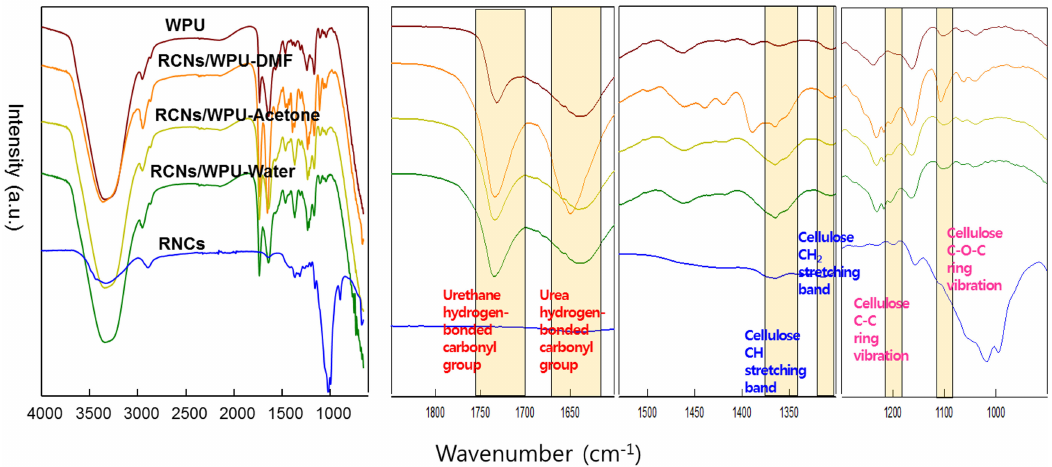
Figure 3. FT-IR spectroscopy bands of WPU, RCNs/WPU nanocomposites, and